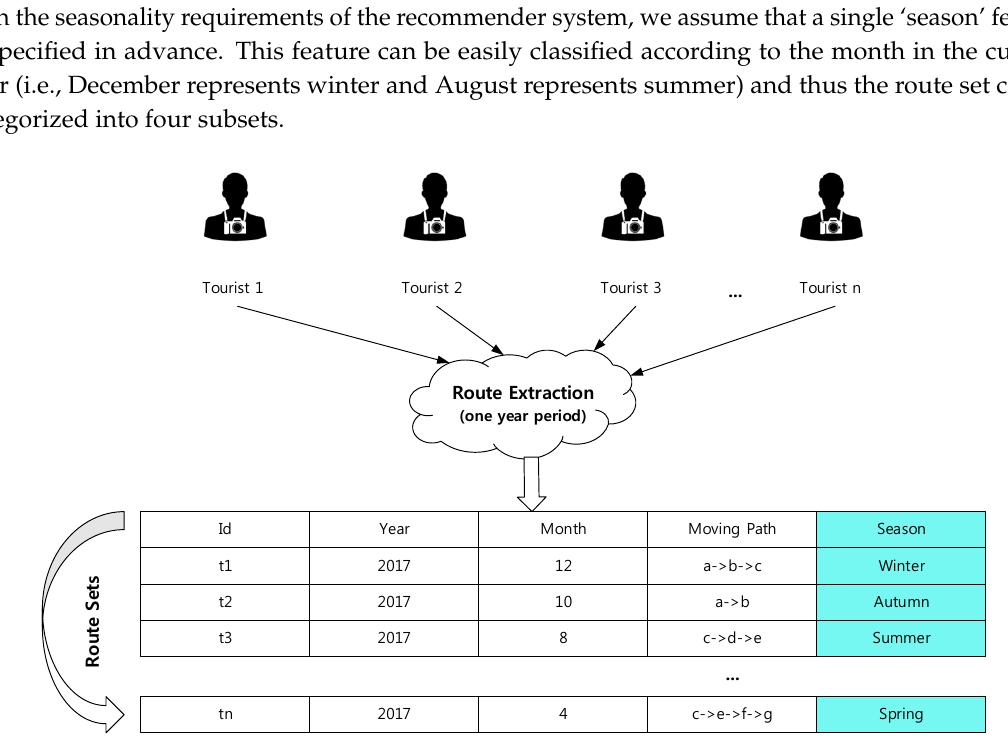
Figure 11. A sample of the extracted route set from the dataset.